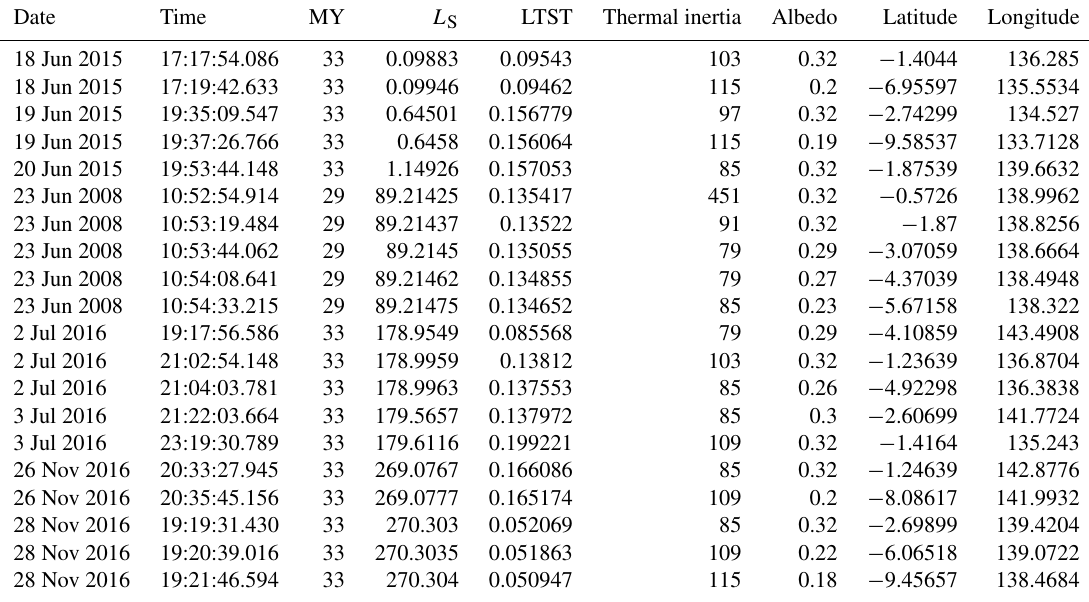
Table A3. MCS sounding details, thermal inertia and albedo for the Curiosity